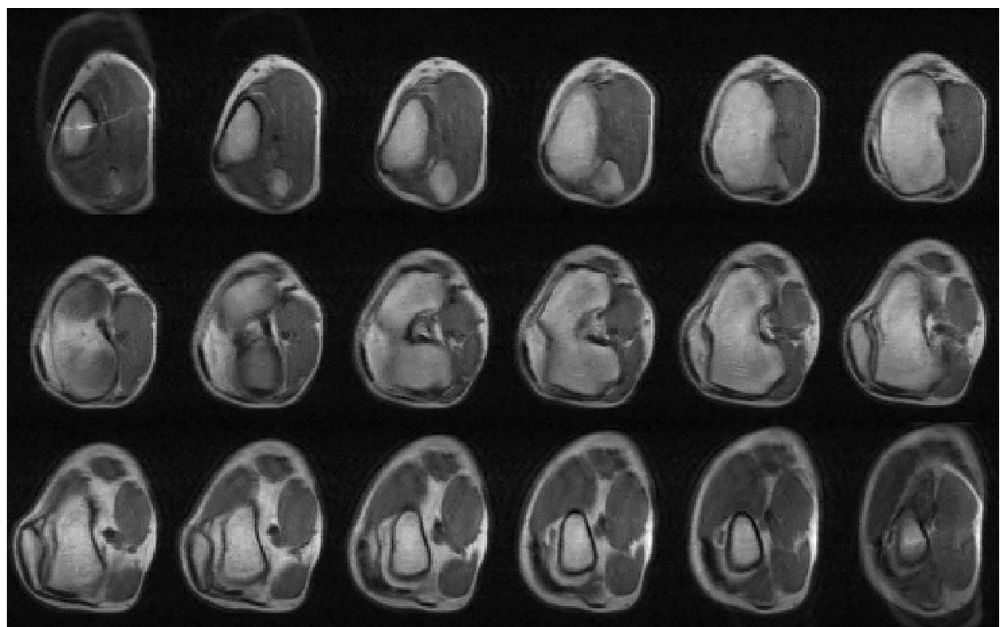
Figure 3. Complete set of axial slices of a T 1 -weighted 3D-RARE knee acquisition (11.5 min), showing small distortions towards the edges of the field of view, and some aliasing between the first (top left) and last (bottom right)